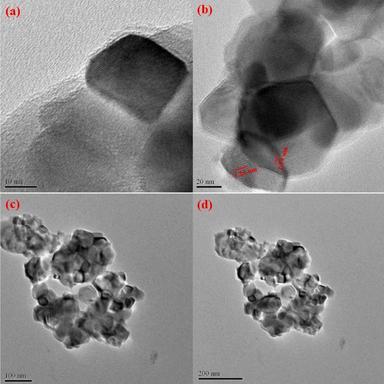
HR-TEM and TEM images of S1 sample at different scale: (a) 10 nm, (b) 20 nm, (c) 100 nm and (d) 200 nm.